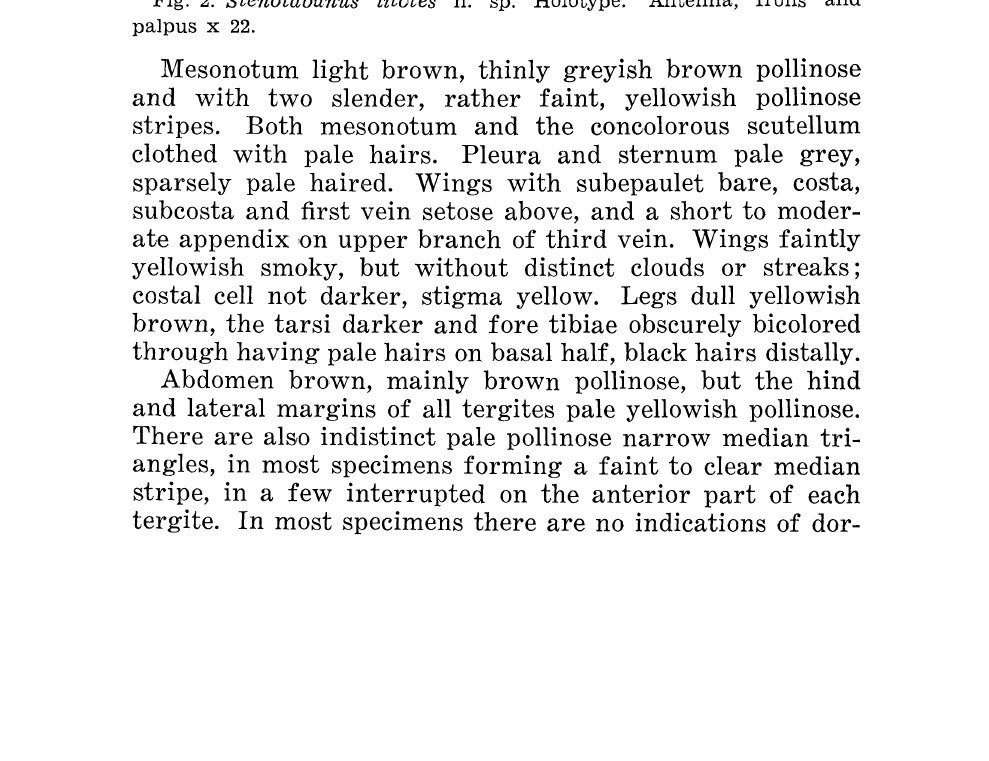
Fig. 2. Stenotabanus litotes n. sp. Holotype. Antenna, frons and pa]pus x